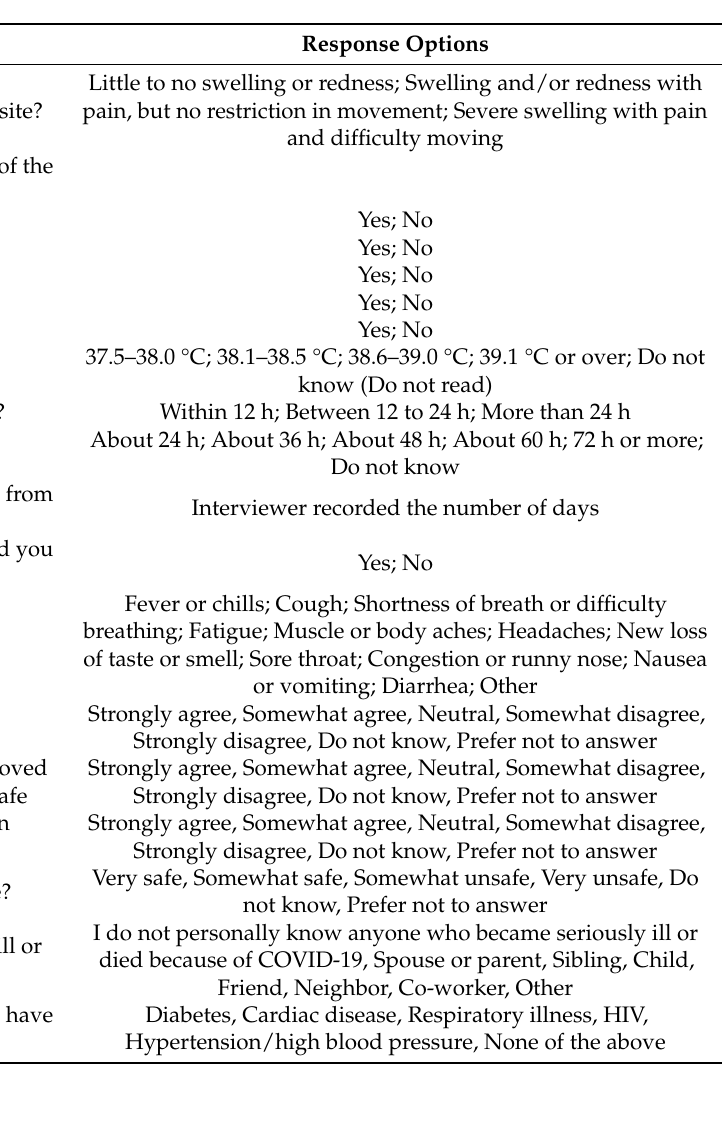
Table 1. Survey questions addressing adverse